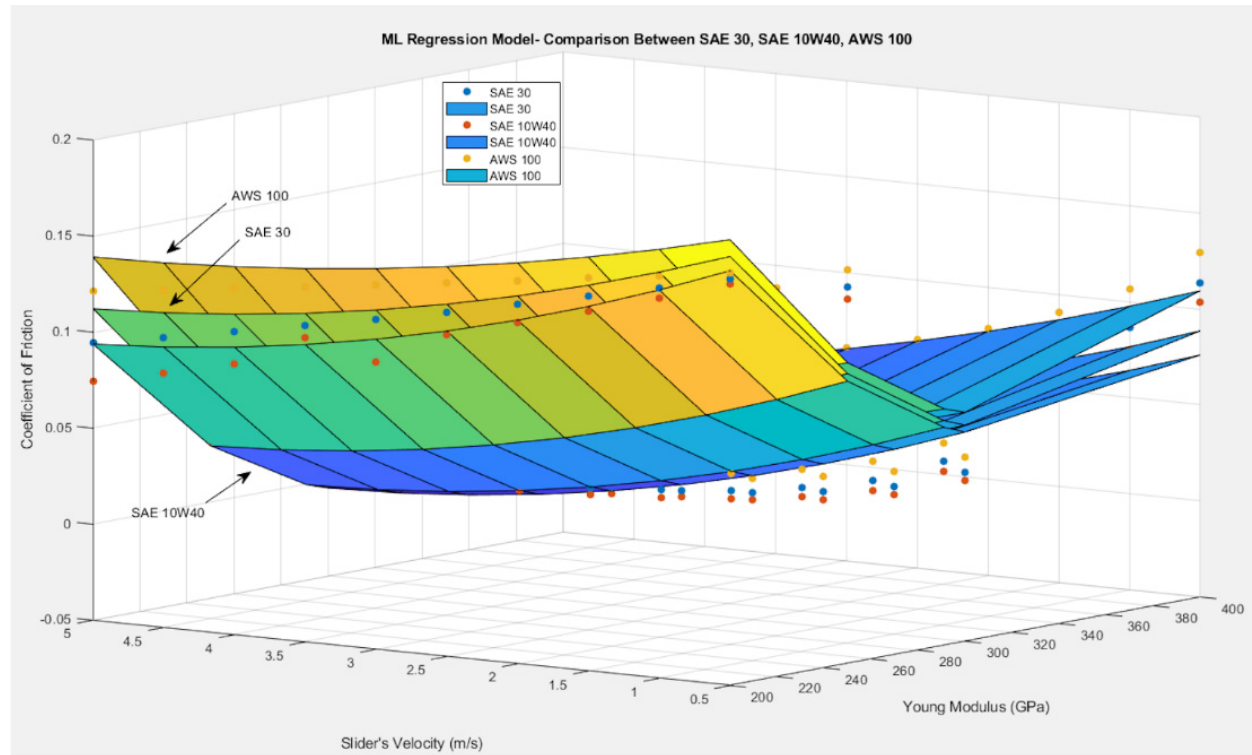
Figure 8. Multi-variable 2nd-order polynomial regression model comparison between SAE 30, SAE 10W40, and AWS 100.